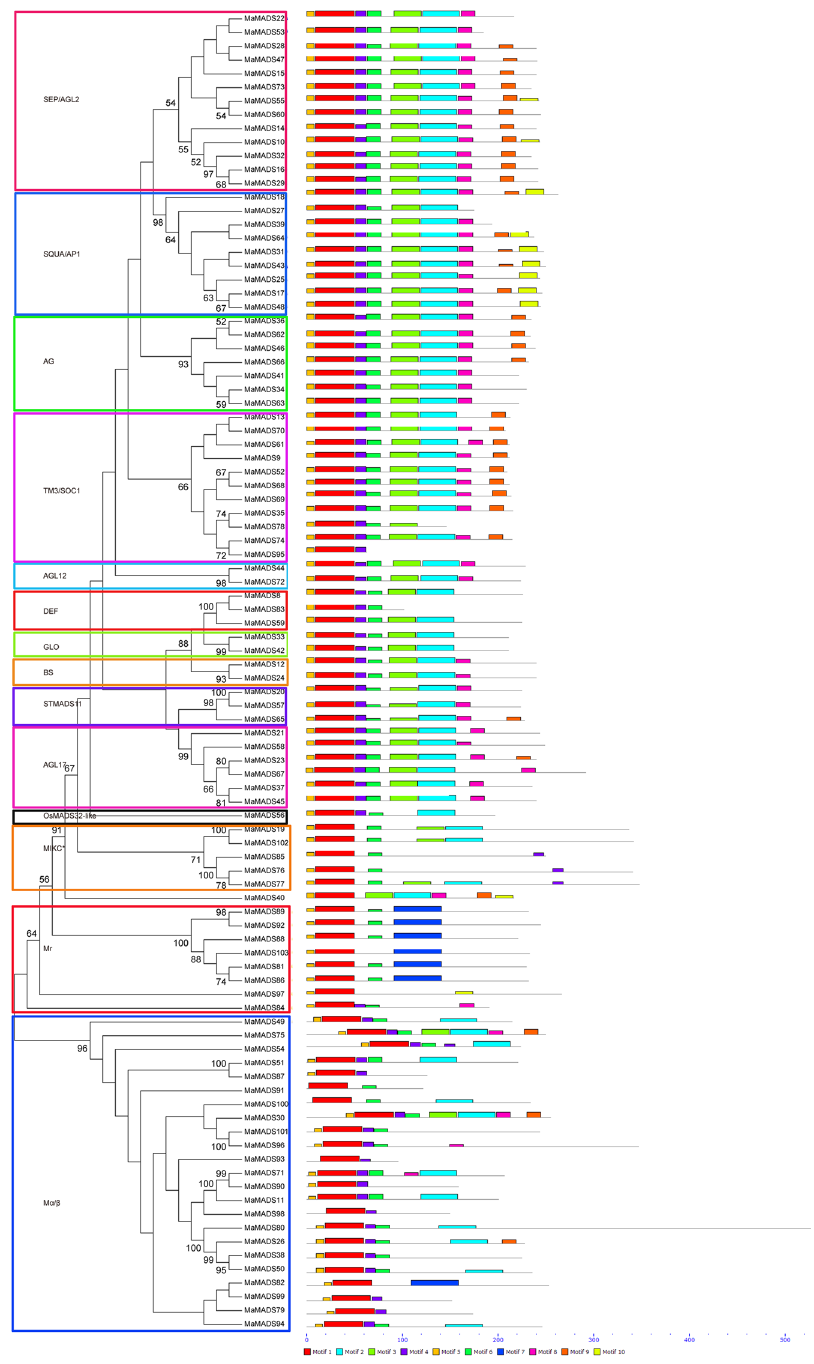
Figure 2. Conserved motif analyses of MaMADSes. All motifs were identified by MEME database with the complete amino acid sequences of MaMADSes. The classification of MaMADSes were shown based on the phylogenetic